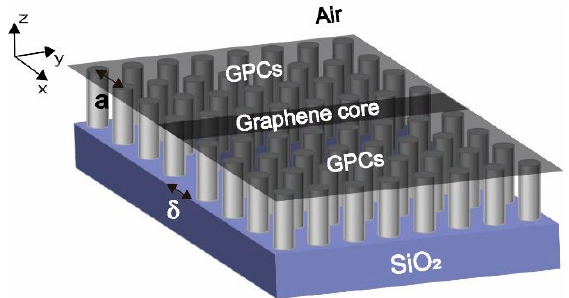
Figure 1. Schematic of the monolayer graphene plasmonic waveguide. From the XYZ coordinate system, a 3D structure, made from a SiO 2 support, can be seen and then tall nanorods are grown on it, and finally there is a flat graphene sheet on the top.